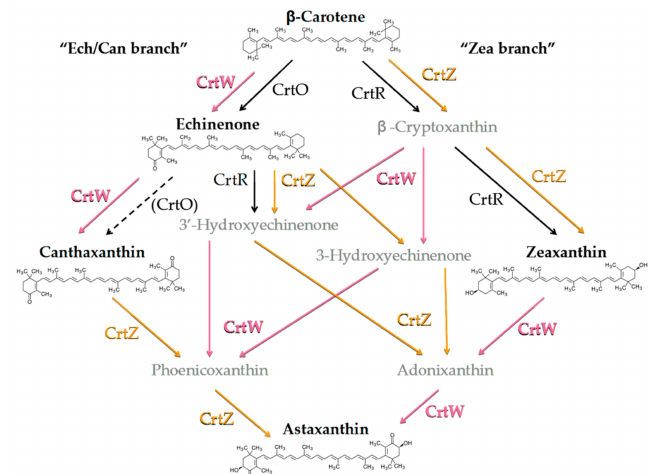
Figure 2. Simplified scheme of the astaxanthin biosynthetic pathway from endogenous β -carotene ( β -car) in engineered Synechocystis strains, resulting from the heterologous expression of Brevundimonas CrtW and CrtZ. The endogenous enzymes CrtO ( β -car ketolase) and CrtR ( β -car hydroxylase) are shown in black. Parentheses and the dashed arrow indicate weak or possible catalytic function. Brevundimonas β -car ketolase (CrtW) and β -car hydroxylase (CrtZ) are indicated in pink and orange letters, respectively. Ech, echinenone; Can, canthaxanthin; Zea,